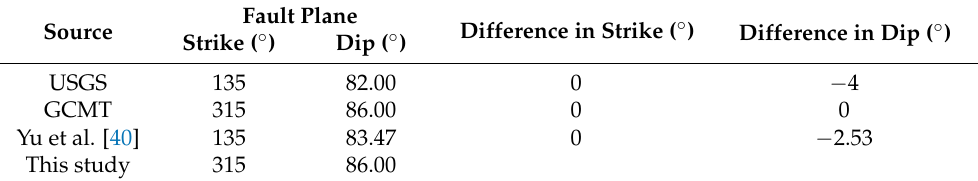
Table 3. Comparison of focal parameters of the 2021 Yangbi Ms6.4 earthquake given by different